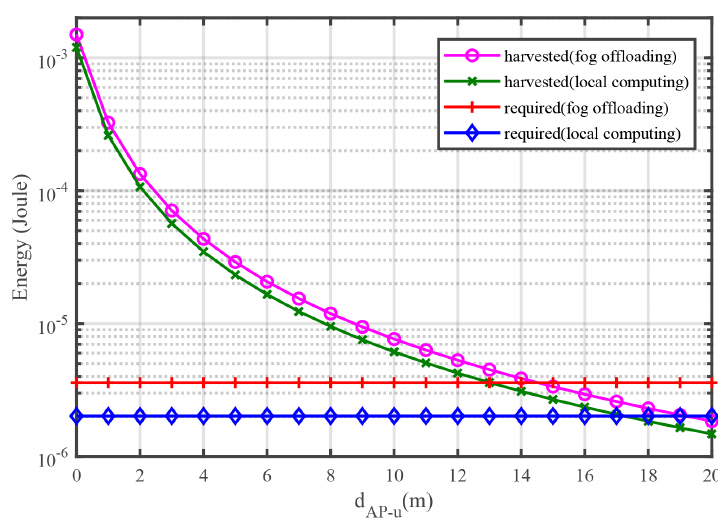
Figure 5. Harvested and required energy per frame versus d AP-u